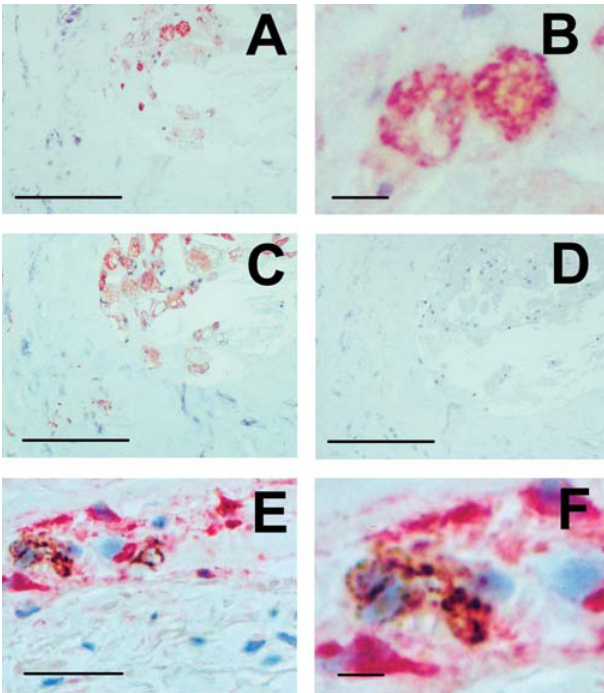
Figure 8. Identification of HIV-1–Positive Macrophages in Atherosclerotic Plaques of HIV-Infected Subjects. Single (A–D) and double (E and F) immunostaining of aortic wall segments. (A) p24 staining. A low-magnification image showing the presence of p24 þ cells in an area adjacent to the plaque lipid core. The scale bar represents 100 l m. (B) Detail of (A). p24 þ cells show a characteristic morphology of foam cells. The scale bar represents 10 l m. (C) CD68 staining. CD68 þ cells were identified in a parallel consecutive section to that shown in (A). The scale bar represents 100 l m. (D) Negative control (staining with an irrelevant primary antibody). The scale bar represents 100 l m. (E) Double immunostaining showing the co-localization of p24 (brown) with CD68 (rose). Immunostaining included a combination of a rabbit polyclonal anti-p24 antibody in the peroxidase–anti-peroxidase system with DAB chromogen yielding a brown reaction product, and a mouse monoclonal antibody to CD68 in the alkaline phosphatase–anti-alkaline phosphatase system with Fast Red chromogen, resulting in a rose precipitate. Counterstaining was with Mayer’s hematoxylin. The scale bar represents 50 l m. (F) A detail of (E). The scale bar represents 15 l m. DOI: